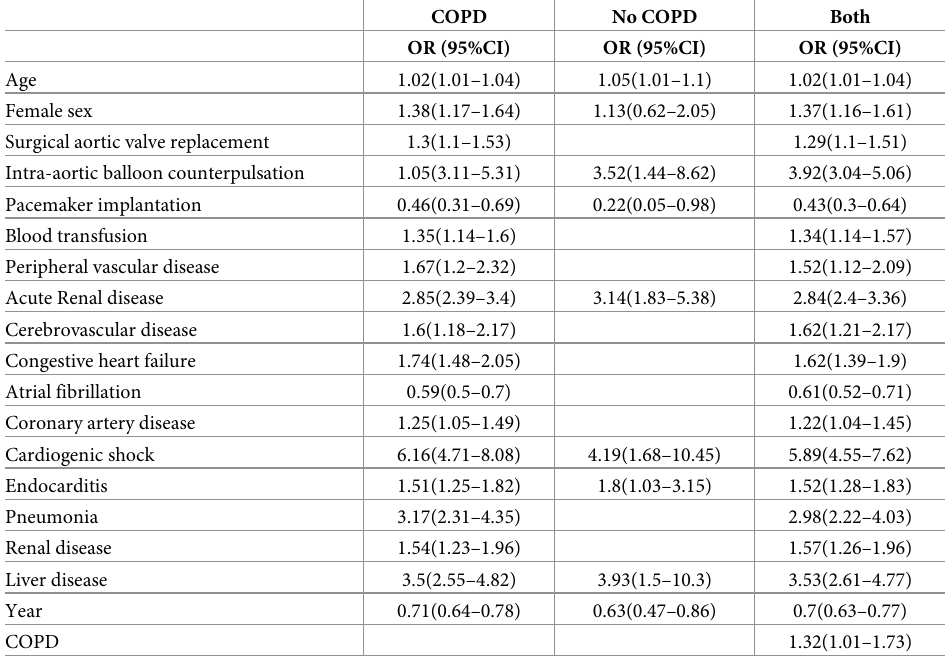
Table 7. Multivariable analysis of factors associated with IHM among COPD and non-COPD patients who under- went bioprosthetic mitral valve